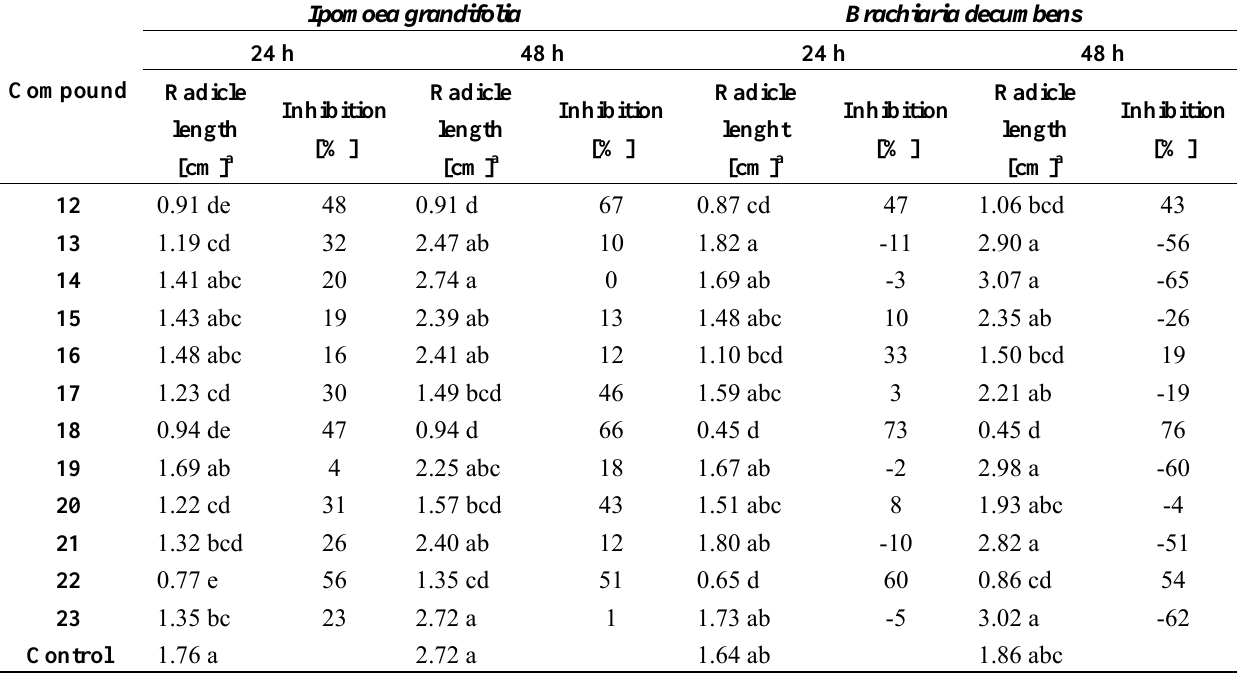
Table 2. Effect of 2,5-bis(alkylamino)-1,4-benzoquinones on the radicle growth of I. grandifolia and B. decumbens at 1.0 × 10 -3